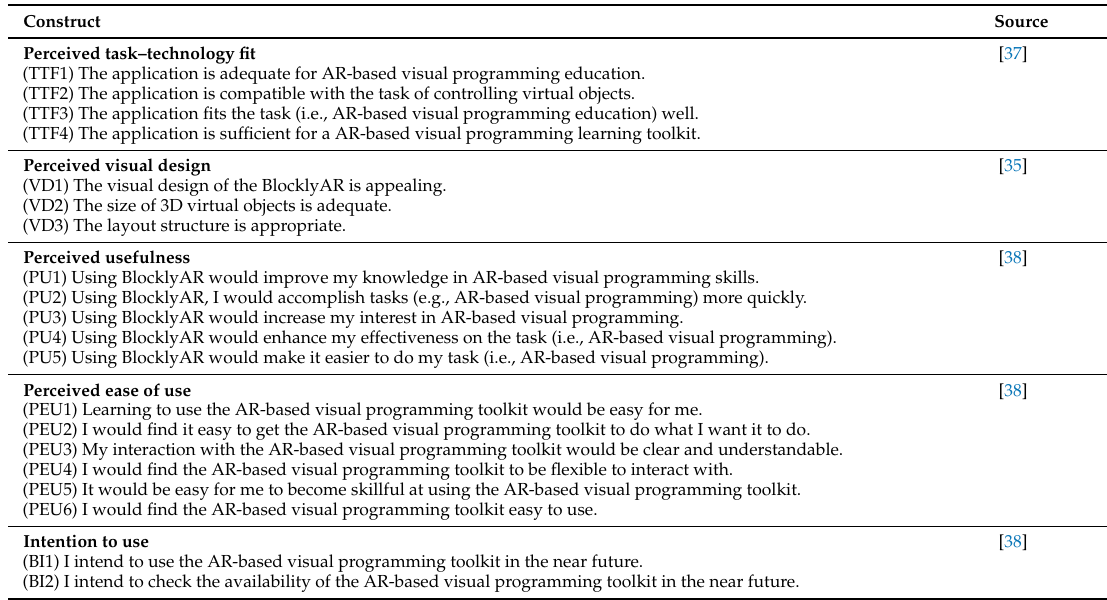
Table 1. Construct and